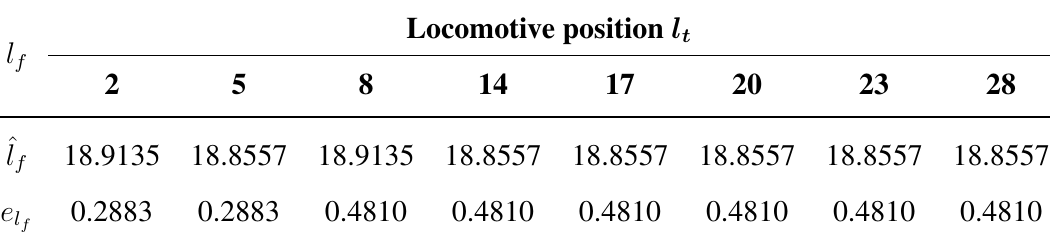
Table 2. The influence of locomotive position on the algorithm.